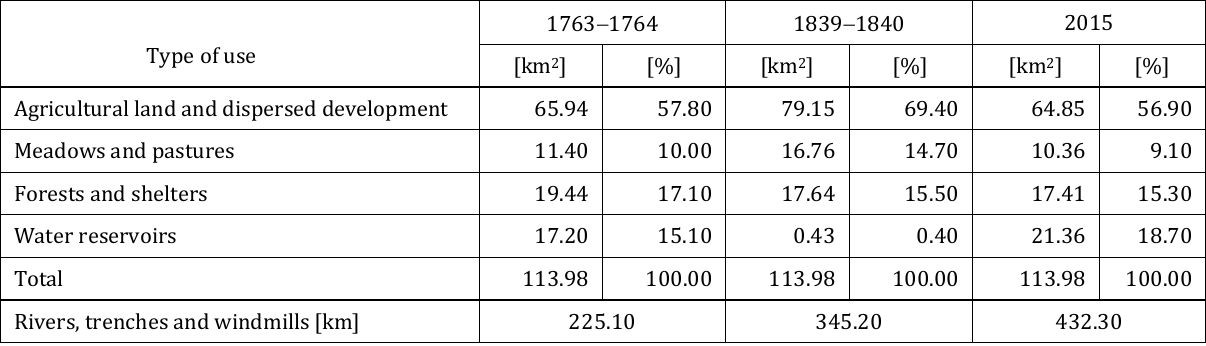
Table 1. Changes in land use in the River Vistula alluvial fan area in the years 1763  2015